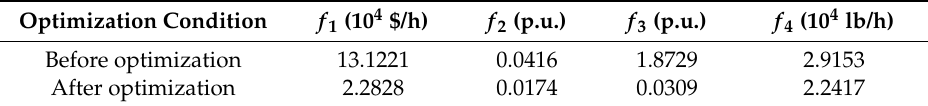
Table 6. Comparison results before and after